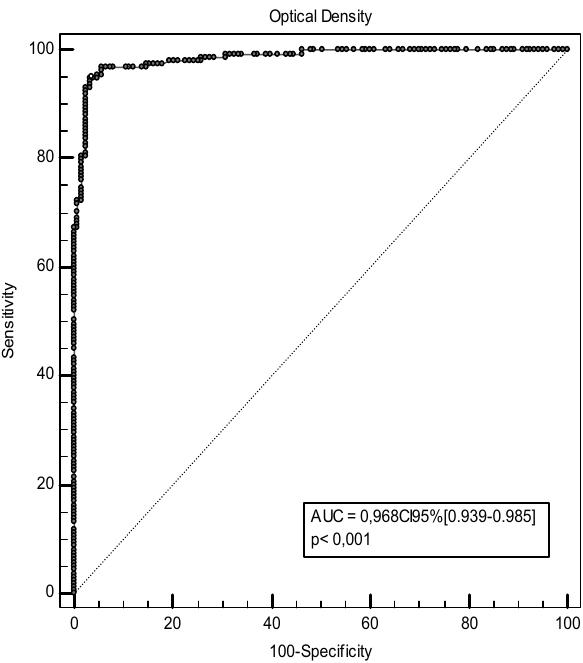
Figure 2. ROC curve for the in-house ELISA using optical density values.